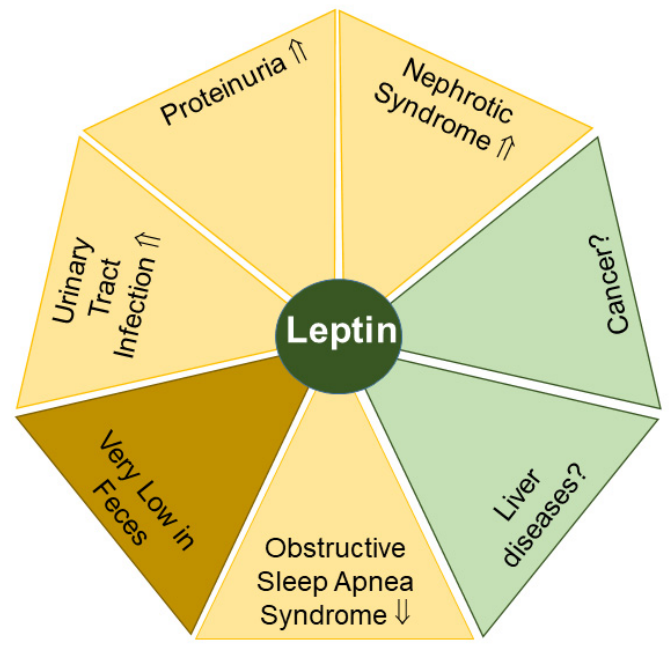
Figure 3. Leptin levels in urine (yellow) may serve as possible biomarkers for the indicated diseases. Significant amounts of leptin in feces (light brown) are difficult to detect. Elevated ( ⇑ ) and reduced ( ⇓ ) leptin levels and a lack of data (?) on leptin levels in urine or feces in patients compared to the respective controls are indicated.